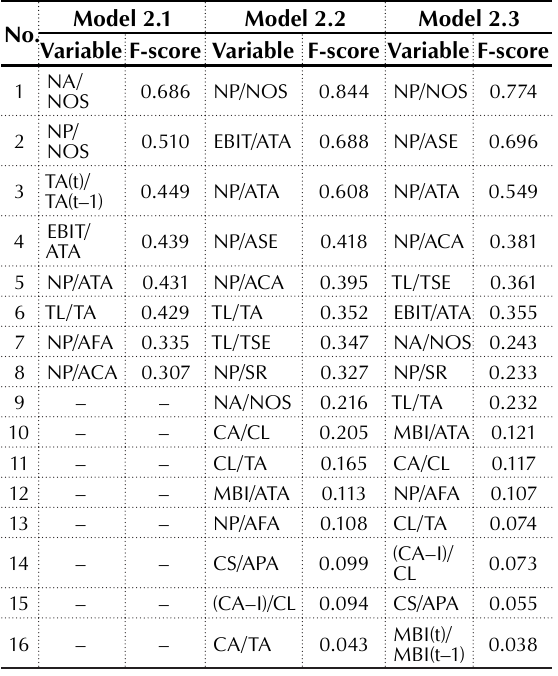
Table 4. Features selected in SVM models – variable set 1